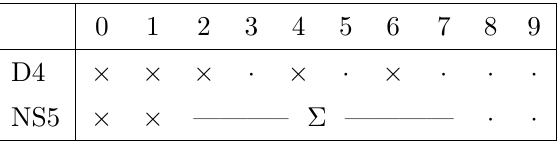
Table 1. Brane brick model